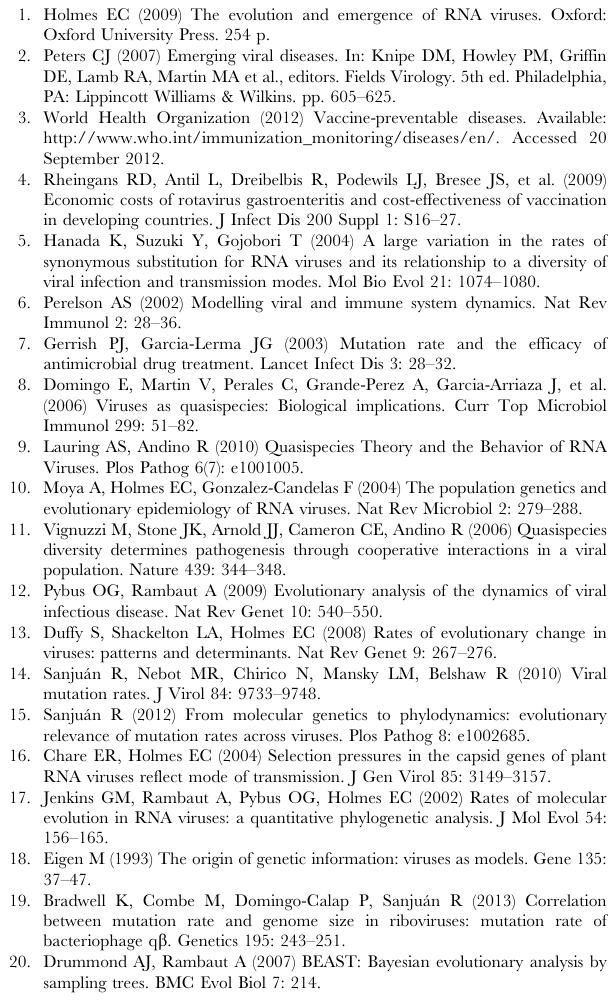
Table S5 Significant predictors of viral substitution rates based on all rates included in this study. For each ANCOVA analysis, the overall adjusted R 2 ( (cid:2) RR 2 ) of the model is given along with the significant predictor variable ( P , 0.01) and its standardized coefficients ( b ) with 95% confidence intervals (CIs). In the first ANCOVA, the base levels were epithelial target cells, fecal-oral/respiratory transmission route, acute/persistent infec- tion, species-specific host range, and dsRNA genome architecture. In the second ANCOVA, the base levels were neural target cells, bites/scratches transmission route, acute infection, order-specific host range, and ( 2 )ssRNA genome architecture. In the third ANCOVA, the base levels were leukocyte target cells, respiratory/ vertical transmission route, acute infection, family-specific host range, and ( + )ssRNA genome architecture. Table S6 Structural gene substitution rate variation among viruses with different cell tropisms. Based on the control datasets with one substitution rate per viral species. The significance of viruses with each target cell in the left column